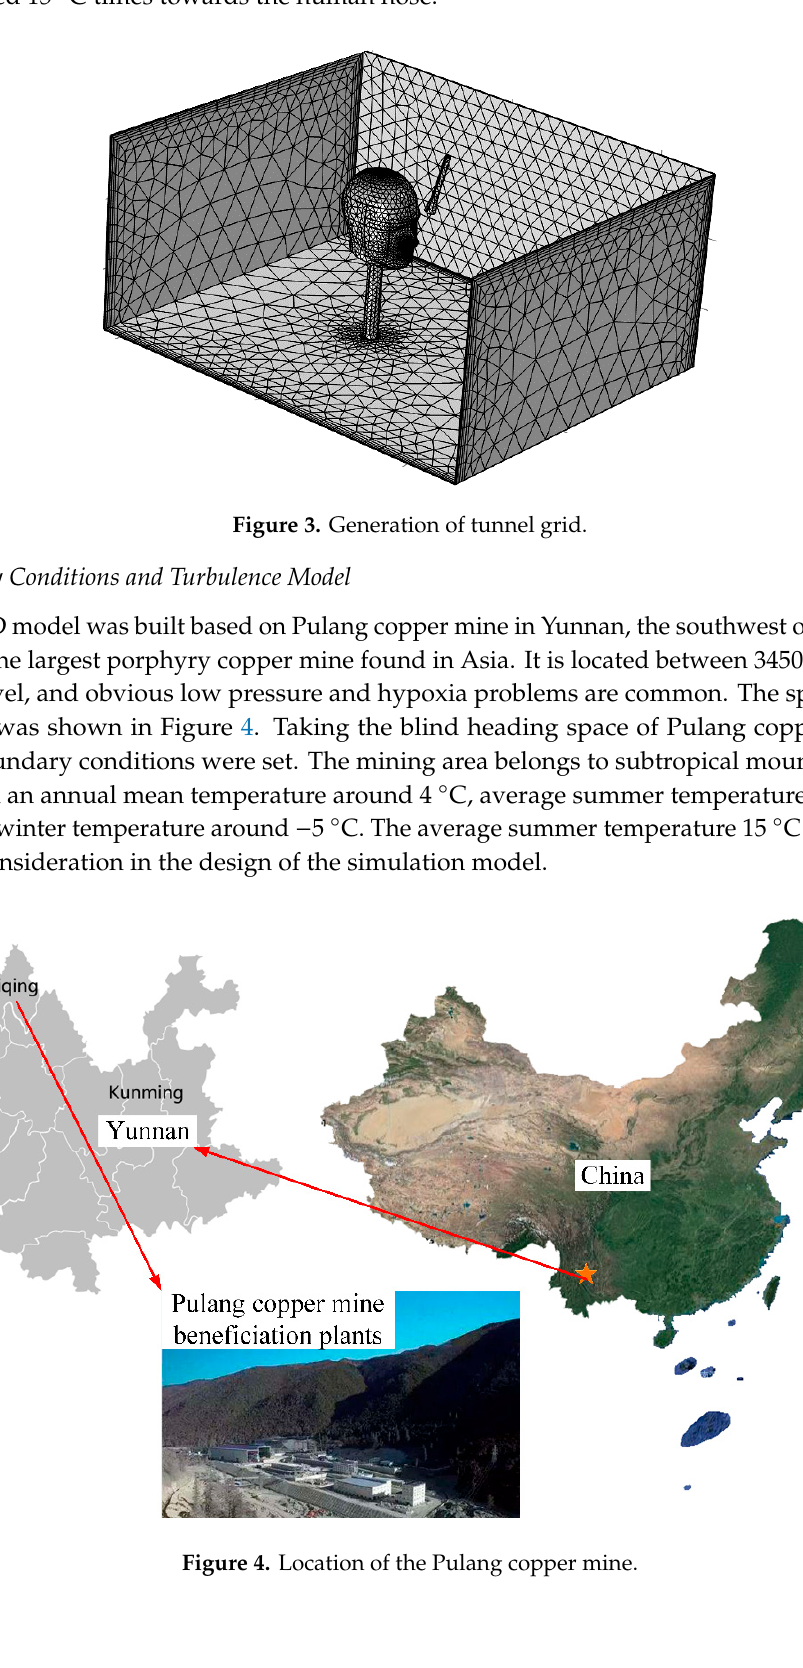
Figure 2. Physical model of individual oxygen-supply device.